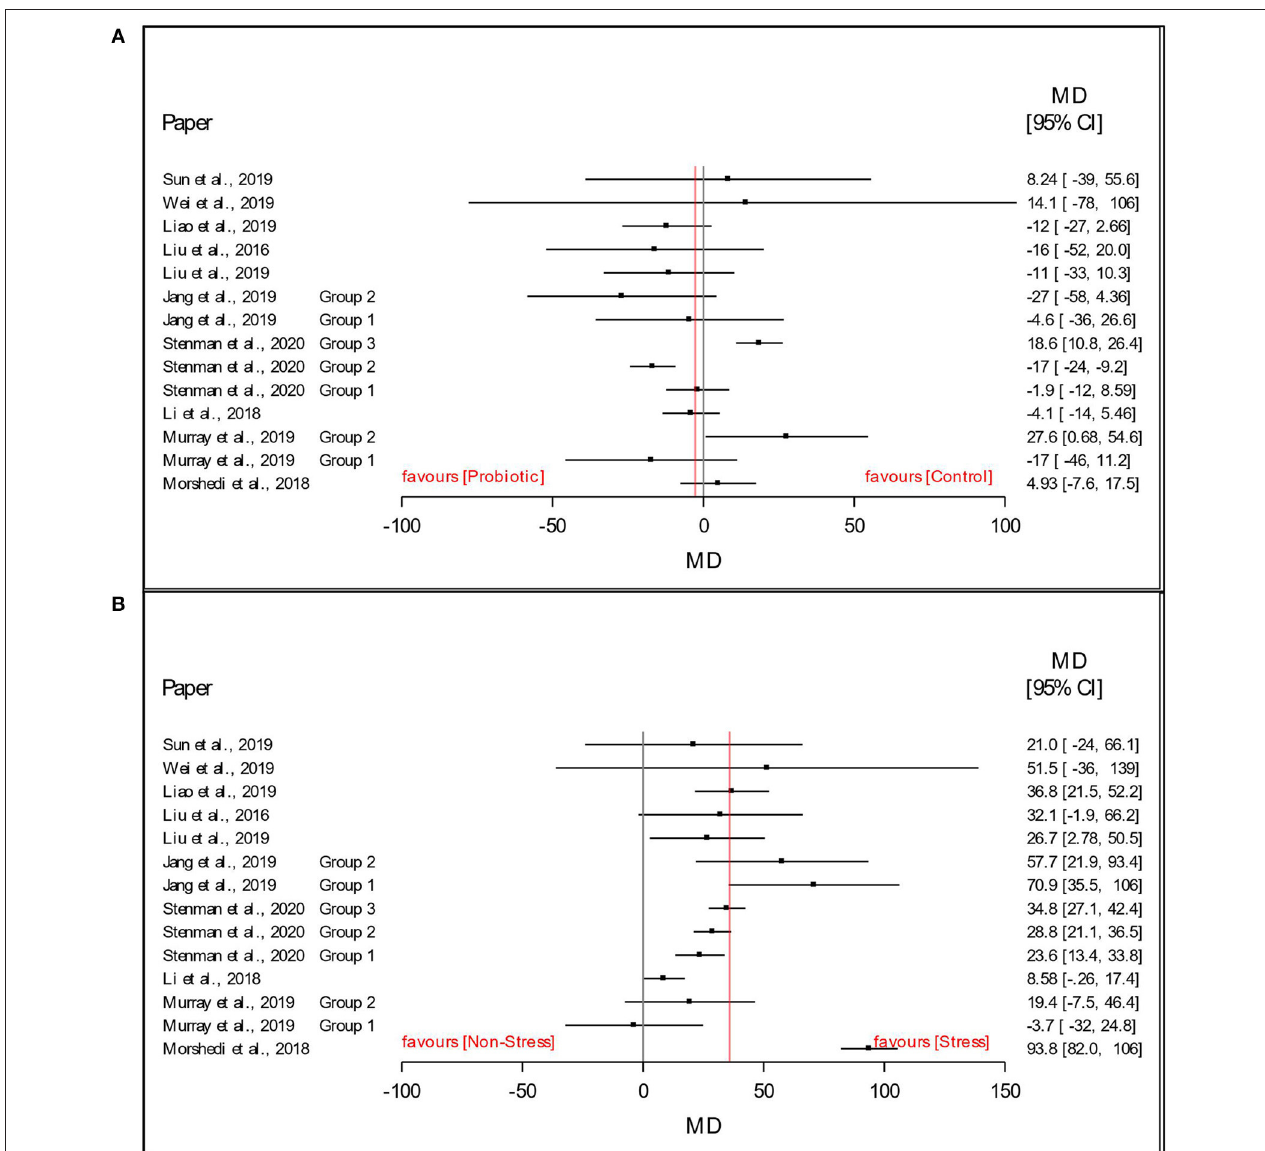
FIGURE 3 | Data and forest plot of the effect of (A) Lactobacillus -based probiotic supplementation and (B) stress on time spent immobile (s) in the Forced Swim Test in rodents for all included studies ( n = 14). Dots represent mean difference (MD, Lactobacillus -based probiotic—Control; stress—non stress) for each study, lines represent 95% CI, and the red line represents the overall fixed effect